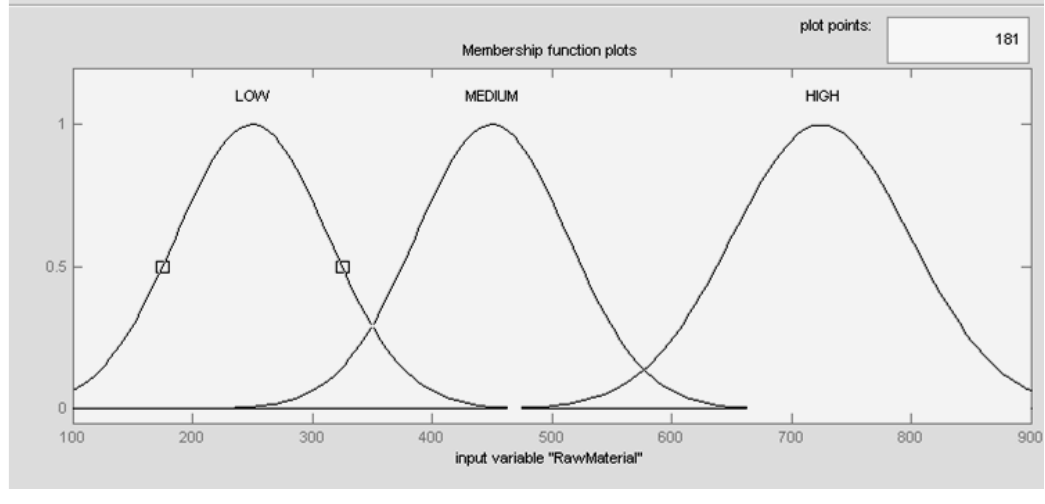
Figure 4. “FIS model for Number of Shift”. Source: Own contribution